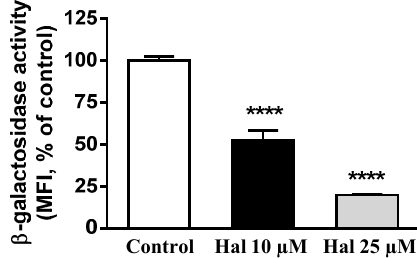
Figure 4. Haloperidol decreases lysosomal β -galactosidase enzyme activity. HepG2 cells incubated in LPDS medium with LDL were kept untreated (control) or treated with haloperidol (10 and 25 µM) for 2 h, then incubated with C 12 FDG for 4 h and analyzed by flow cytometry. Results are mean ± SEM of three independent experiments. MFI, median fluorescence intensity. Statistical comparisons shown are haloperidol versus control (**** p < 0.0001).